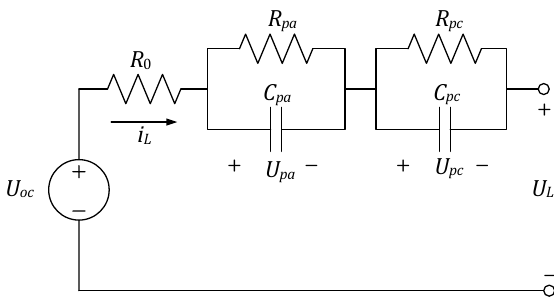
Figure 1. Schematic of the second-order RC model.